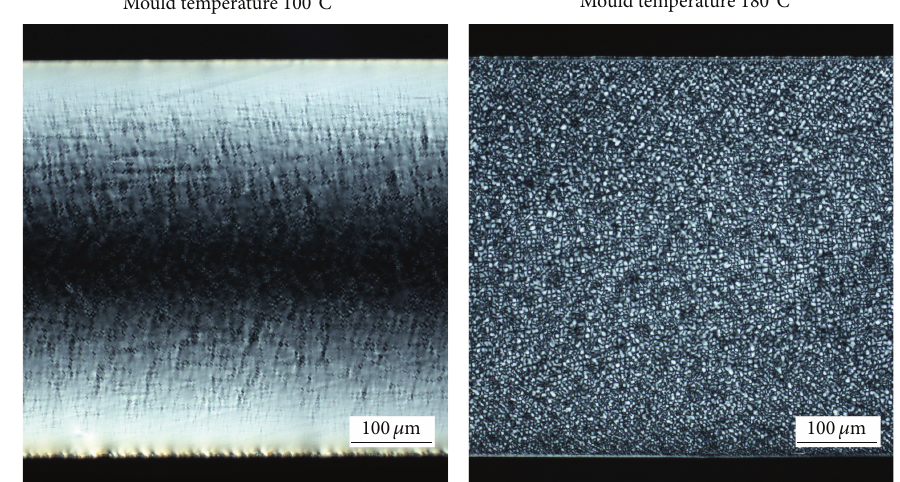
Figure 5: Morphology of the PA66 tensile bars.